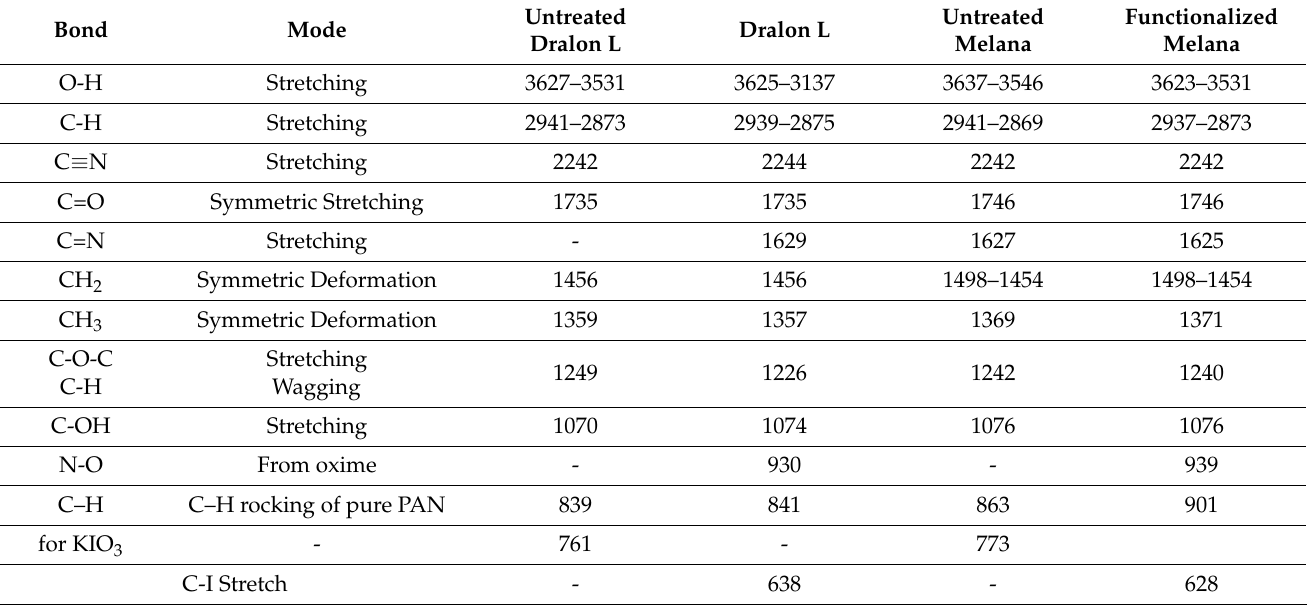
Table 3. FTIR adsorption bands of PAN fibers before and after functionalization with KIO 3